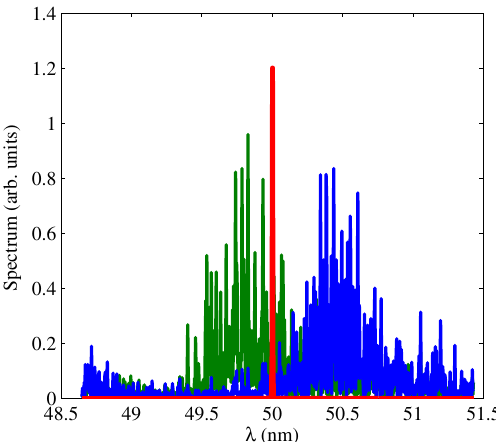
FIG. 2. The red line represents the coherent photon beam from undulator, while others represent the undulator spontaneous emission. All spectra are from GENESIS [39] simulations, where two undulator resonant wavelengths λ R ¼ 49 . 7 nm (green line) and λ R ¼ 50 . 5 nm (blue line) are used. The central wavelength of coherent photon beam is unchanged for different undulator resonant wavelengths. The real amplitude of the red is ∼ 10 3 larger than the blue